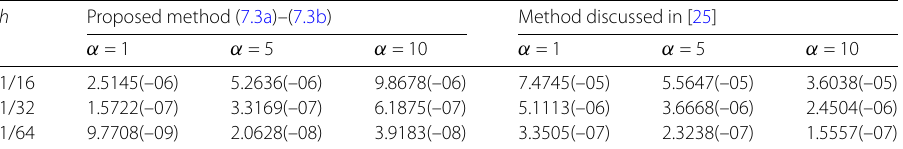
Table 9 Problem 8.9: The maximum absolute errors